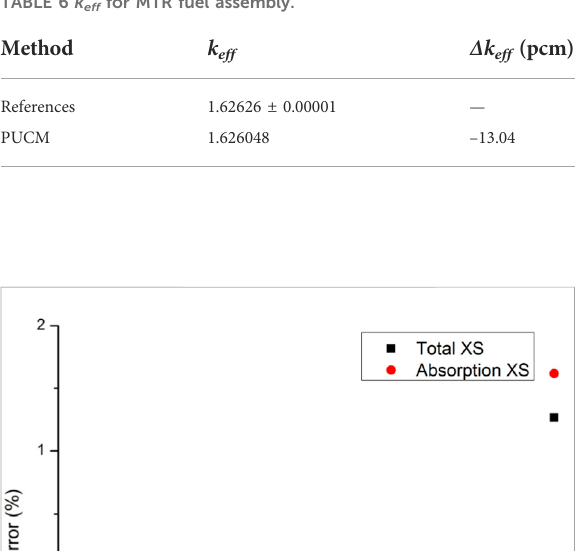
TABLE 6 k eff for MTR fuel assembly.